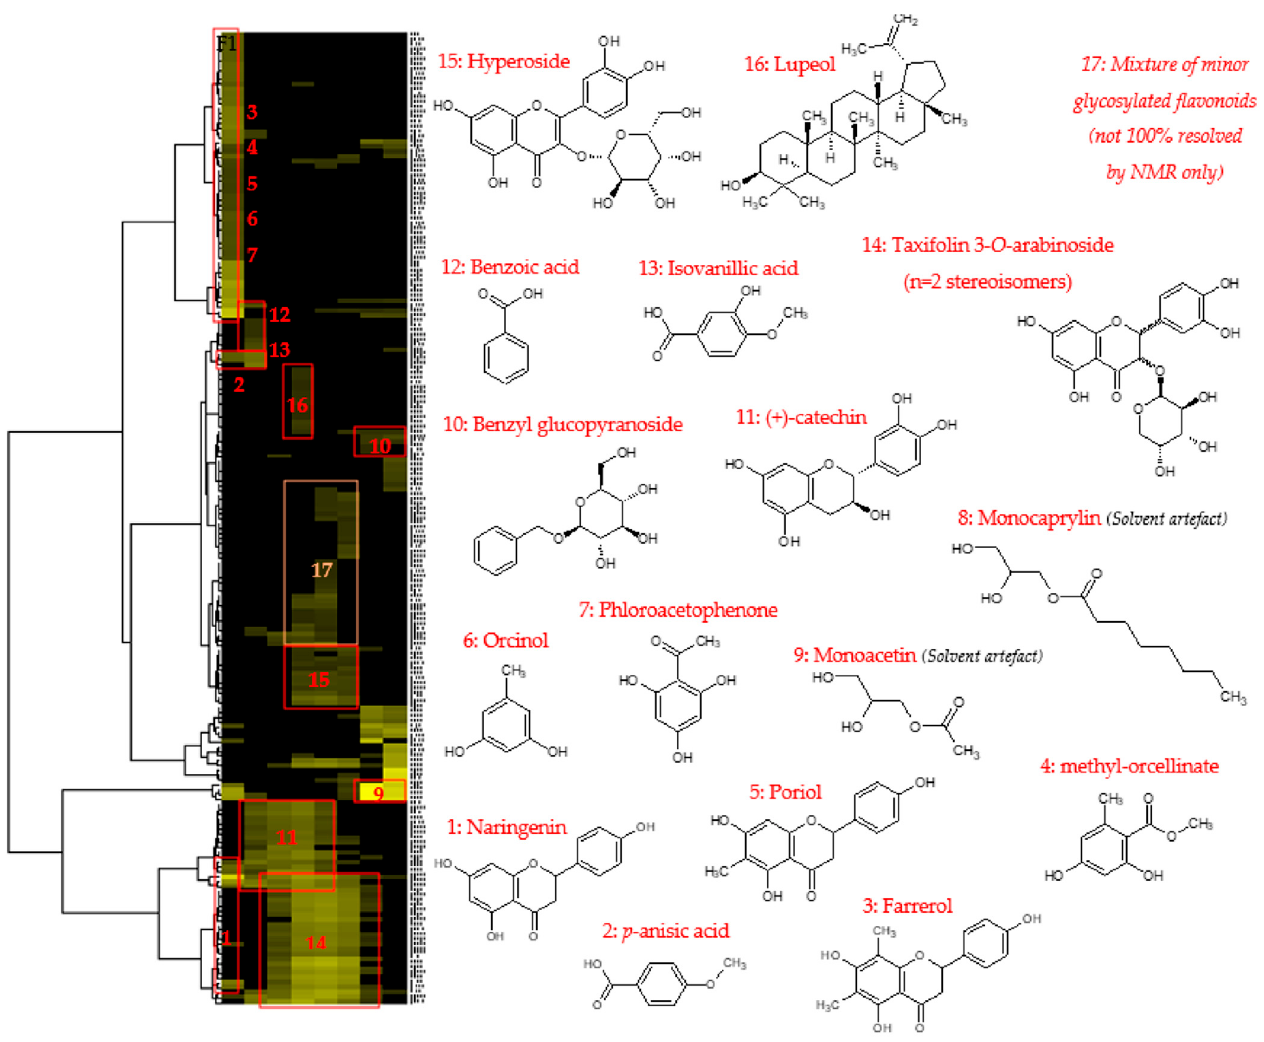
Figure 3. HCA correlation map of 13 C NMR signals with the identified